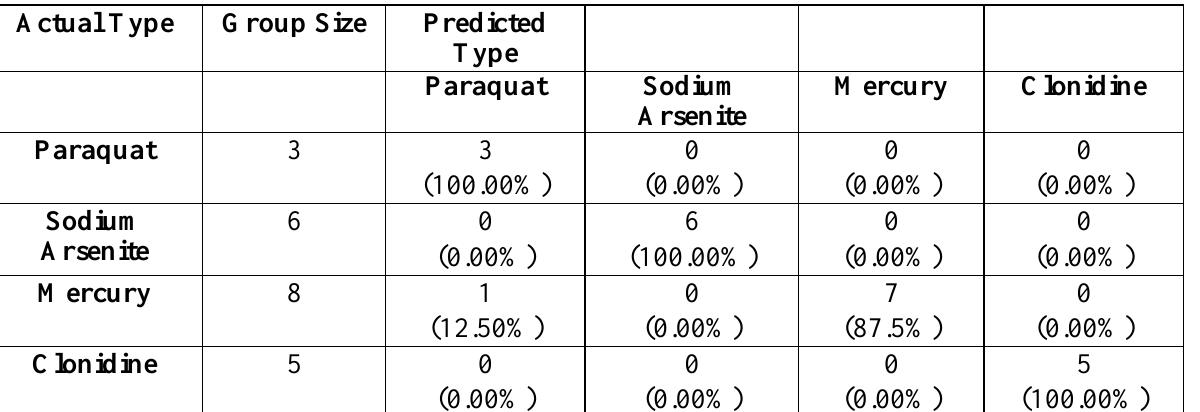
Table 2. Classification for Combined Case with seven explanatory variables. This table represents a quantitative output of the classification efficiency of the discriminant functions for the combined case, which utilized both cell types. The table is read left to right and shows how the discriminate functions predicted the toxin that was present following the training procedure. Overall classification efficiency was